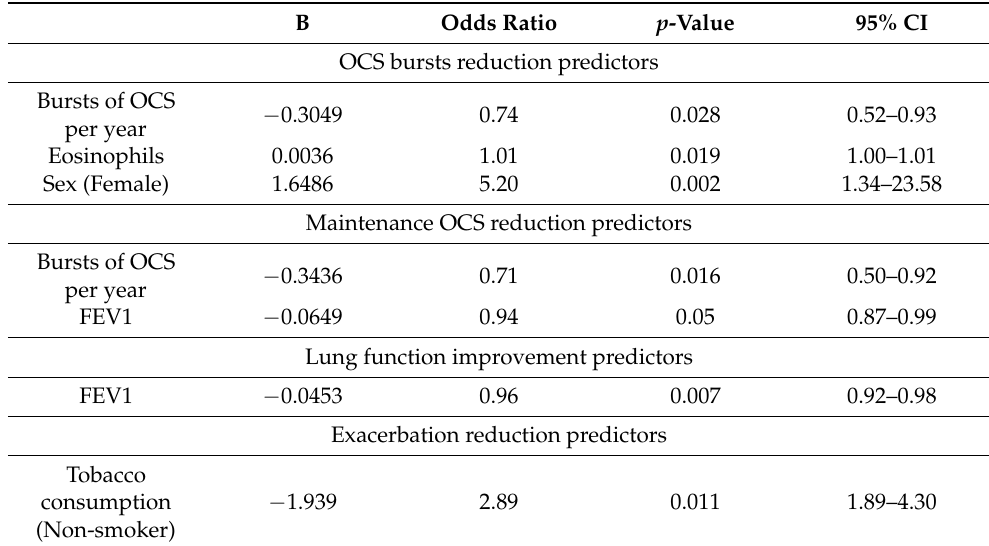
Table 7. Predictors of response after 12 months of treatment with benralizumab in patients with severe uncontrolled asthma (multivariate